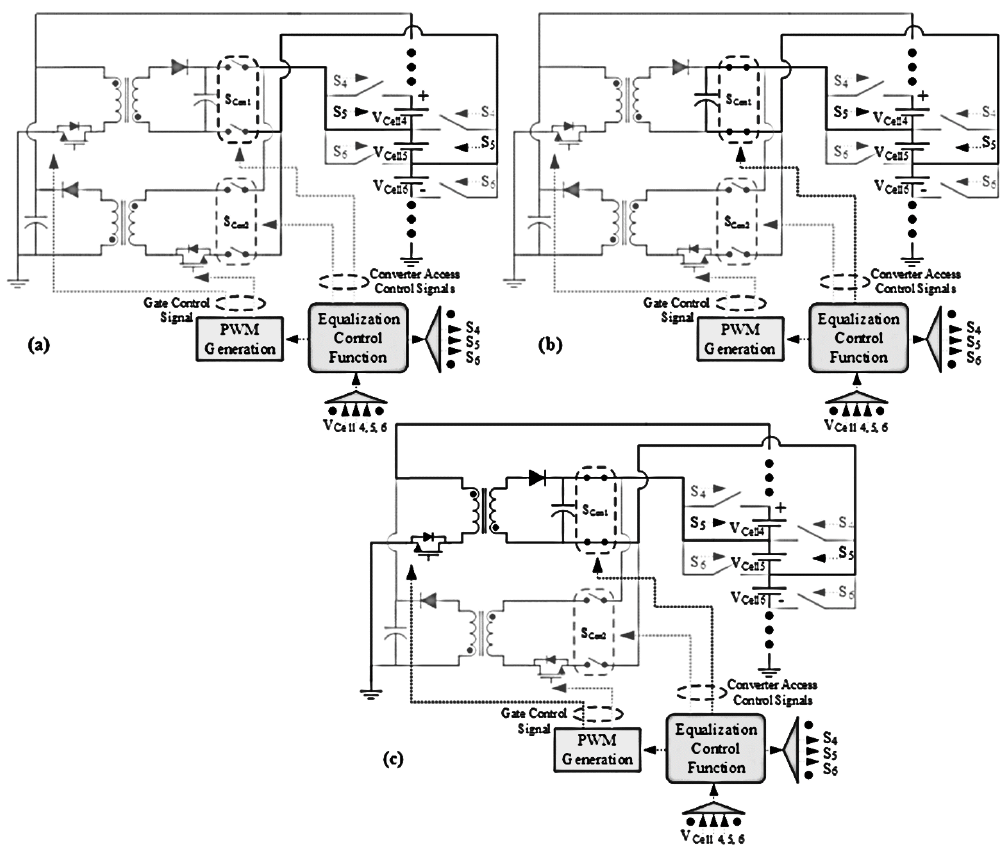
Figure 8. Operational steps of the charge equalization controller model. ( a ) Step 1; ( b ) Step 2; ( c ) Step